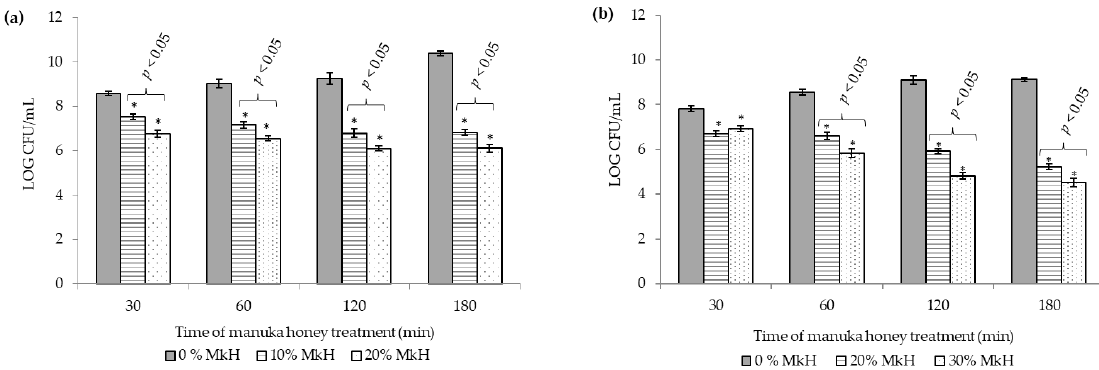
Figure 1. Effect of MkH on S. aureus CECT 86 ( a ) and E. coli CECT 515 ( b ) cell viability assessed by colony forming units (CFU) counting (expressed in Log 10 units) by plating on Mueller–Hinton Agar. Data at each time point corresponds to mean ± standard deviation. NS indicate no significant differences and asterisks indicate significant differences (*: p < 0.05; **: p < 0.01; ***: p < 0.001) between treated cells vs. the control (non-treated cells). p- values, indicate significant differences ( p < 0.05) between the two honey concentrations tested.